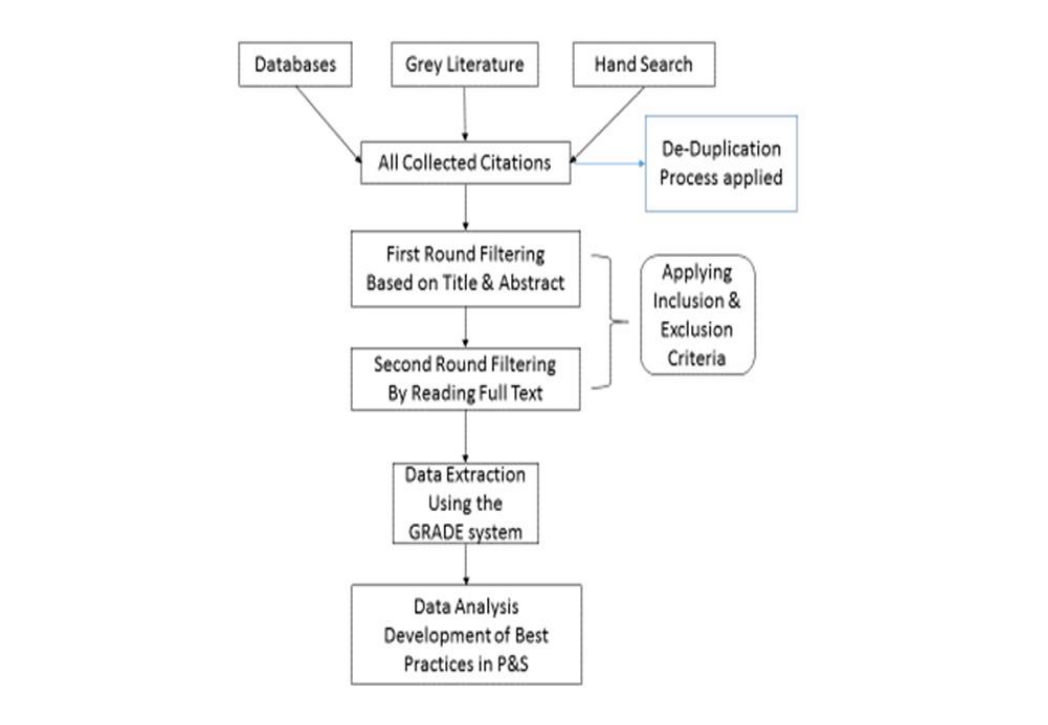
Figure 1. Flow chart to summarize